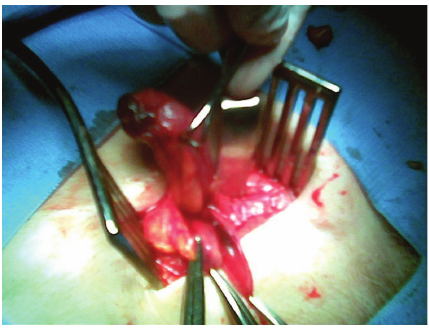
Figure 2: Intraoperative picture from exploration of femoral